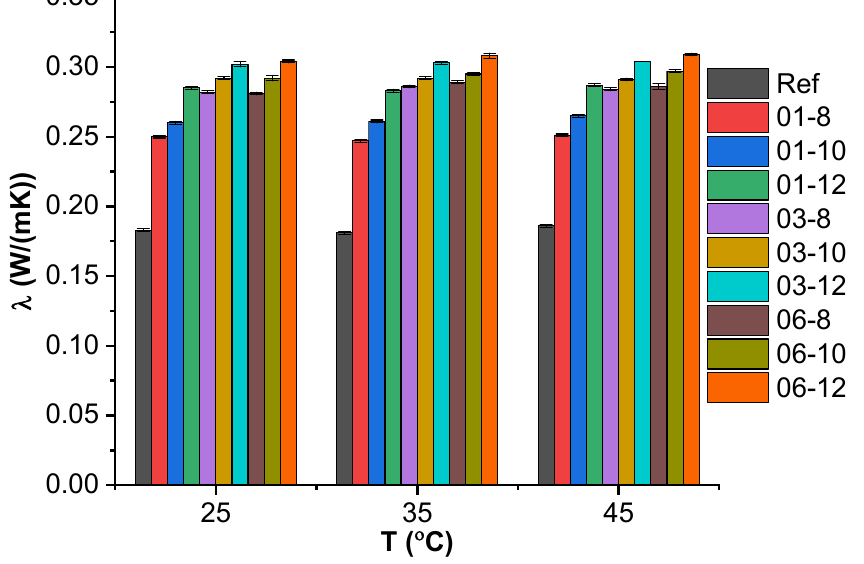
Figure 2. Thermal conductivity of hybrid composites at 25, 35, and 45 °C.